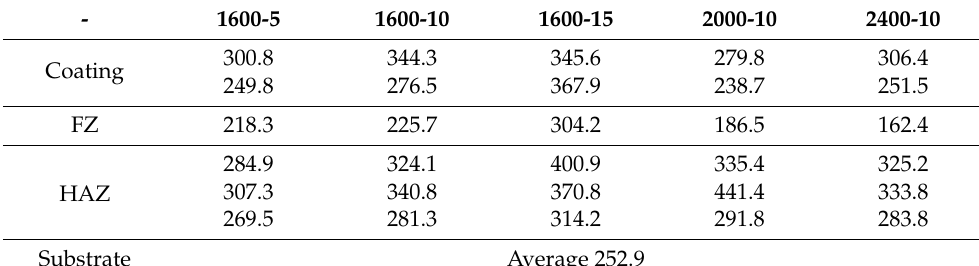
Table 3. Microhardness (room temperature) from coating to the substrate, HV 0.2